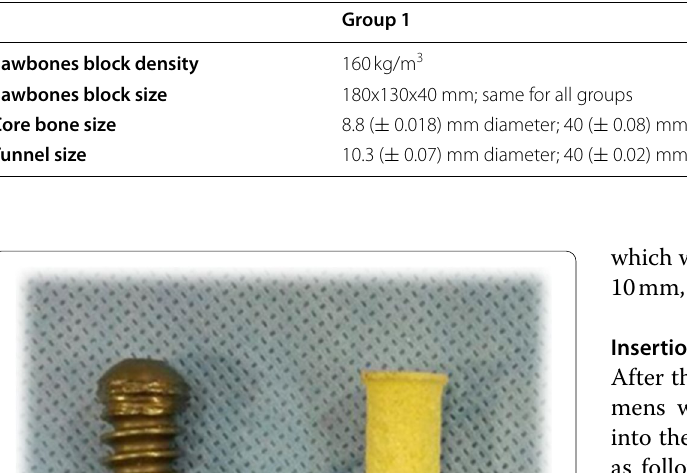
Table 2 Geometric aspects of prepared components for experiments